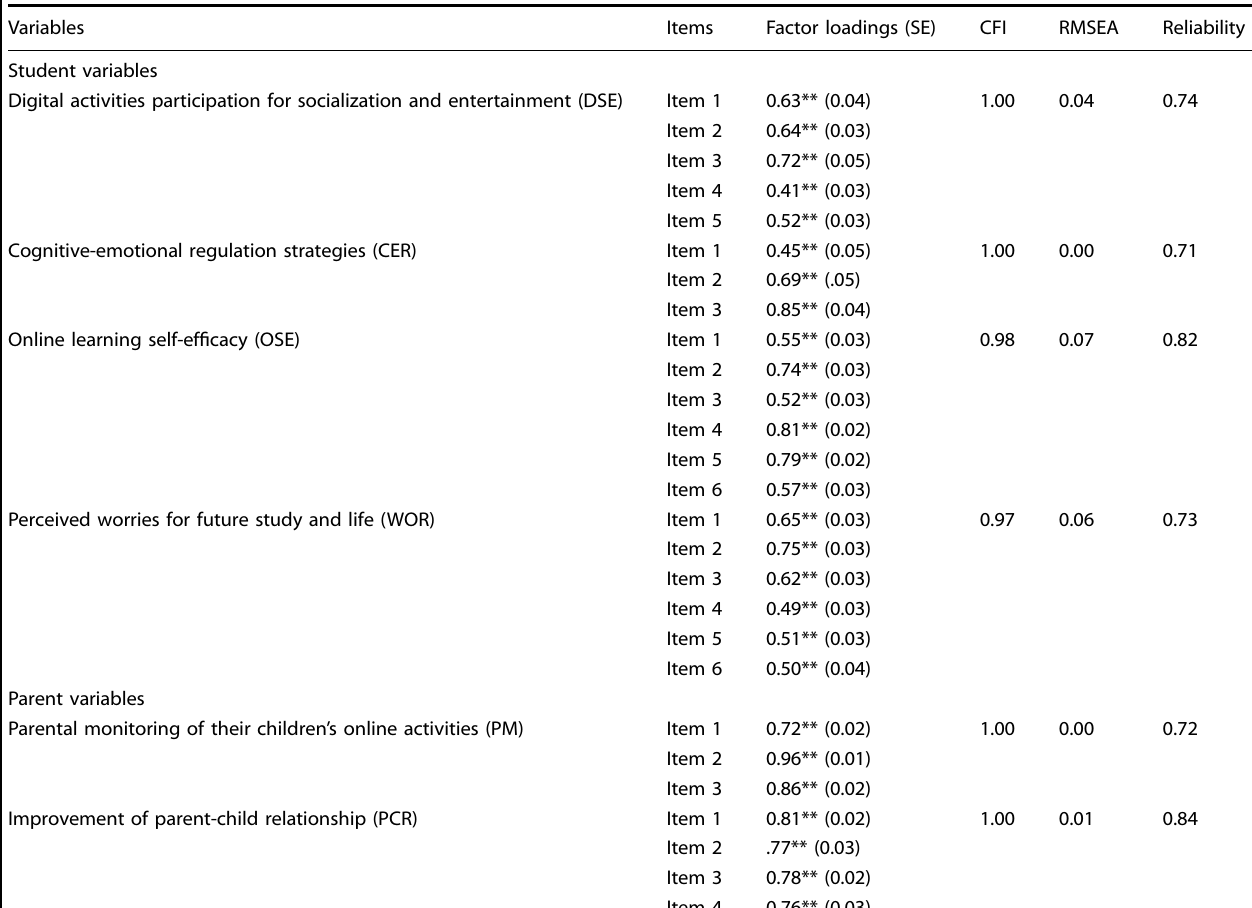
Table 1. Results of construct validity and